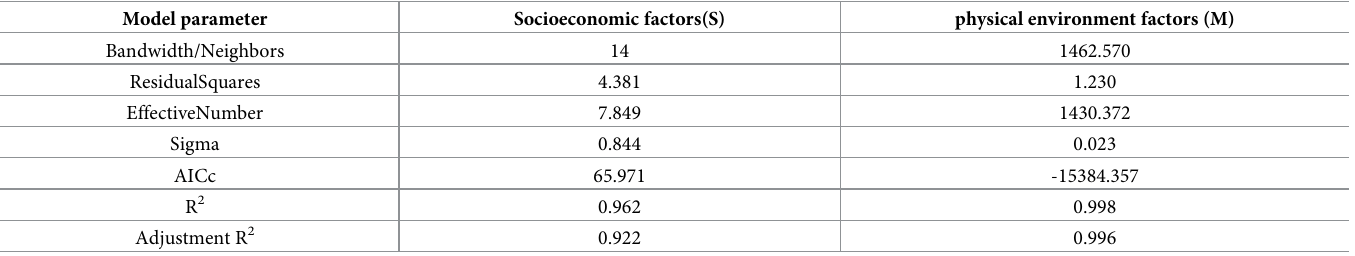
Table 3. Test result of the GWR